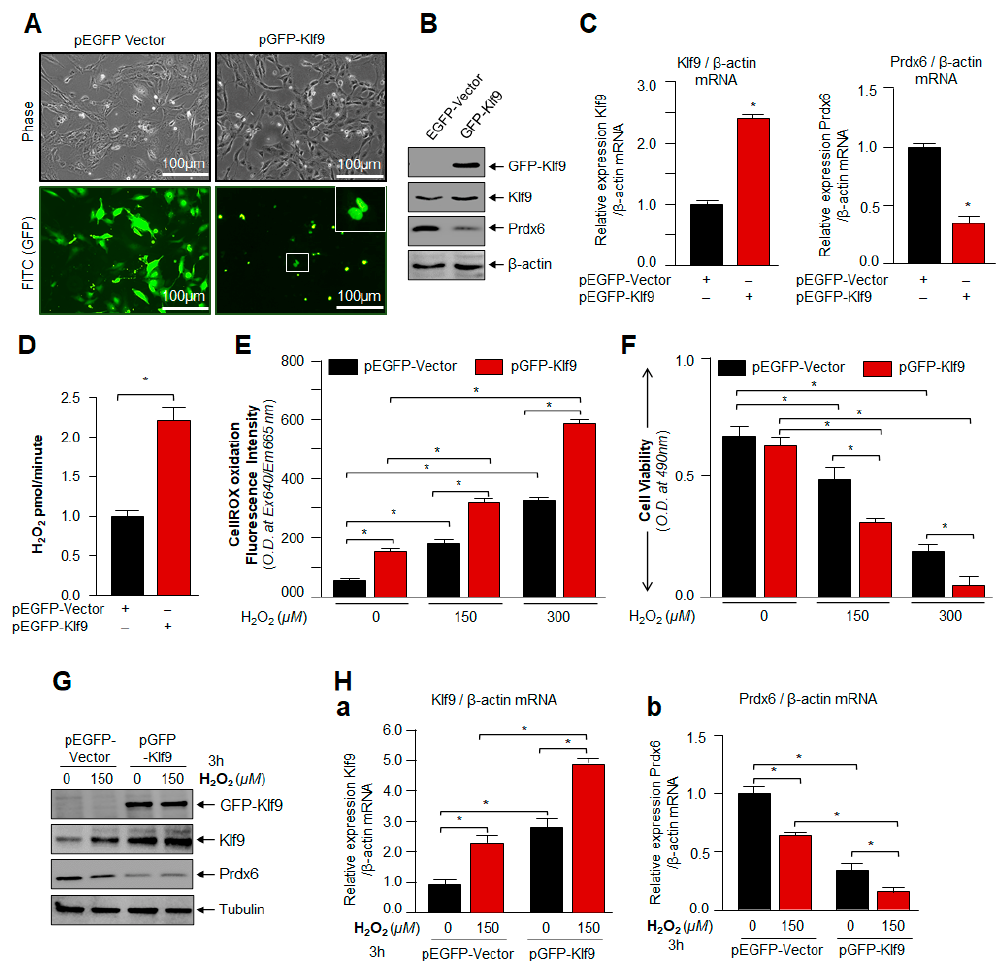
Figure 4. Overexpression of Klf9 generated high production of ROS and H 2 O 2 with reduced hLECs viability compared to empty vector during oxidative stress. hLECs were overexpressed with pEGFP-Vector or pGFP-Klf9 plasmid. ( A – H ) hLECs were transfected with Klf9 plasmid using Neon transfection system and harvested and photomicrograph was taken ( A ). Then, 48 h later, total protein and RNA were isolated from 60mm plates and proceed for Western blot ( B ) and mRNA ( C ) analyses. ( D ) Transfectants were harvested in 96-well plate, and H 2 O 2 generation of cells were quantified. Data represent the mean ± S.D. of three independent experiments. * p < 0.001; pGFP-Klf9 vs. pEGFP-Vector transfected hLECs. ( E , F ) To assess effect of H 2 O 2 , transfectants (96-well plate) were exposed to 0, 150 and 300 µM of H 2 O 2 . 3 h of H 2 O 2 exposure ROS level (E) and at 24 h cell viability (F) was examined. * p < 0.001; pGFP-Klf9 vs. pEGFP-Vector transfected hLECs and H 2 O 2 (150 µM and 300 µM) treated vs. untreated (0 µM) hLECs. ( G , H ) LECs overexpressing pGFP-Klf9 were highly sensitive to oxidative stress and showed reduction in Prdx6 expression. hLECs were overexpressed with pEGFP-Vector or pGFP-Klf9 plasmid. 48 h later, complete media were replaced with 0.2% BSA, and cells were exposed to different concentration (0 and 150 µM) H 2 O 2 . After 3 h of H 2 O 2 exposure, total protein ( G ) and RNA ( H ) were isolated and expression levels were examined by western blot and qPCR, respectively. Data represent the mean ± S.D. of three independent experiments. * p < 0.001; H 2 O 2 treated versus control and pGFP-Klf9 vs. pEGFP-Vector transfected hLECs.